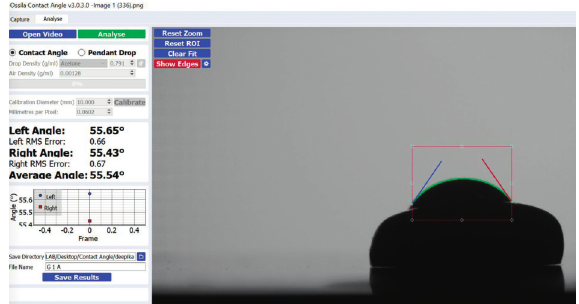
Figure 7: Contact angle measurement of the included